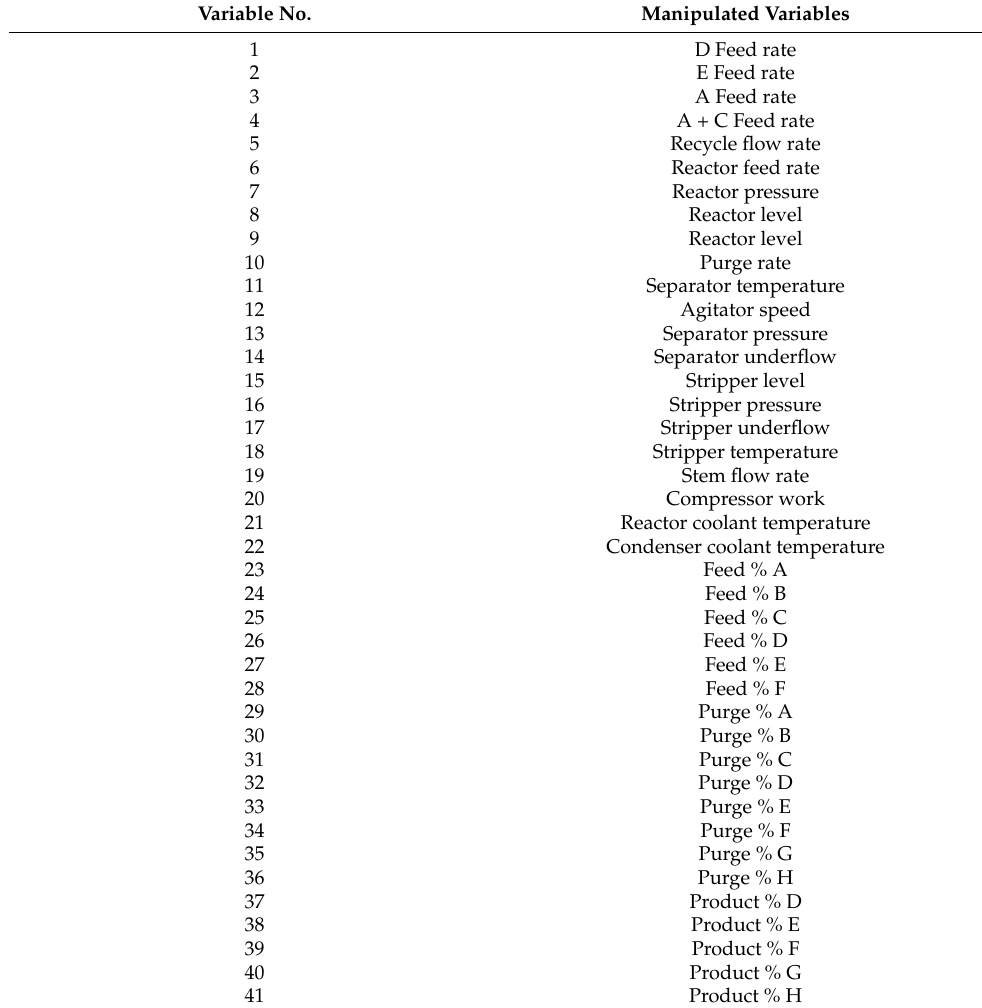
Table 5. Measurement variables in the Tennessee Eastman process.